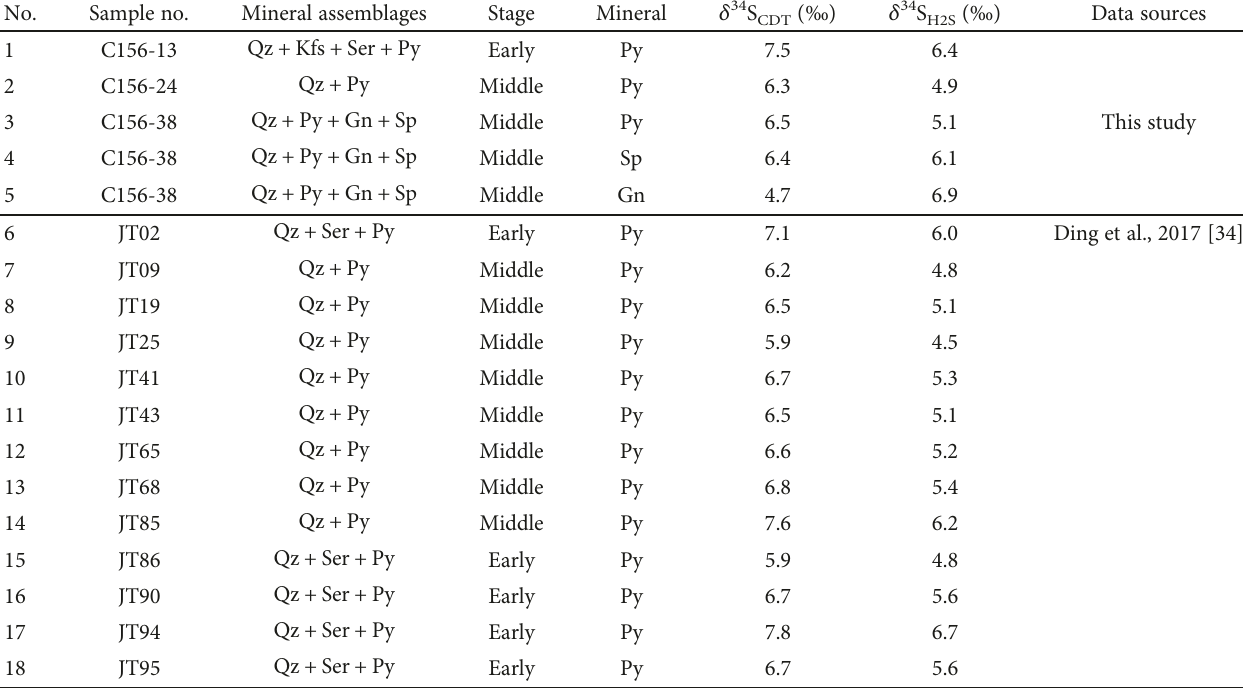
Table 4: Sulfur isotope compositions for sul fi des from the Xiejiagou gold deposit. No.